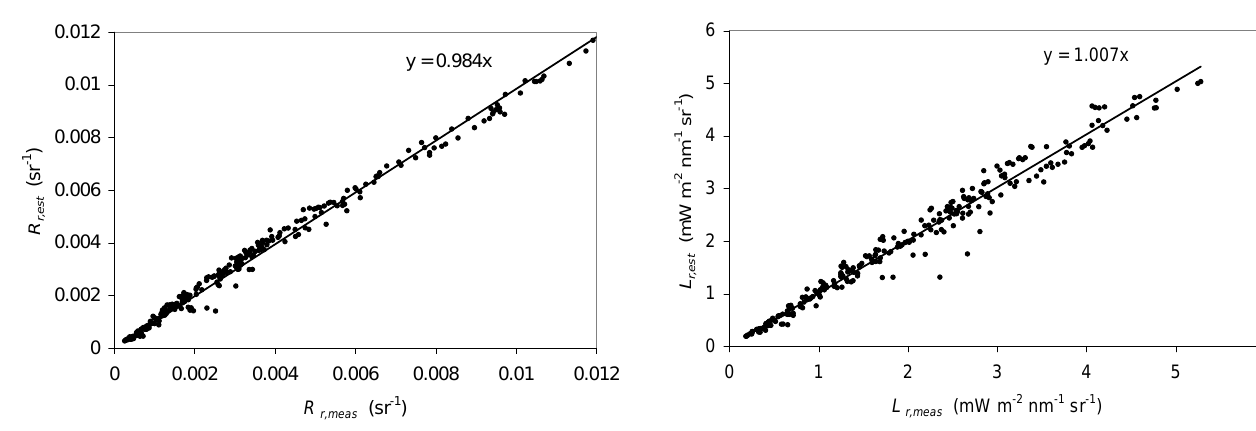
Figure 5. Estimated vs. measured values of the reflected radiance L r for all data sets and wavelengths. Table 4. Mean values of measured radiance reflectance R r, meas and reflected radiance L r, meas , and the rms deviations between these quantities and the corresponding estimated